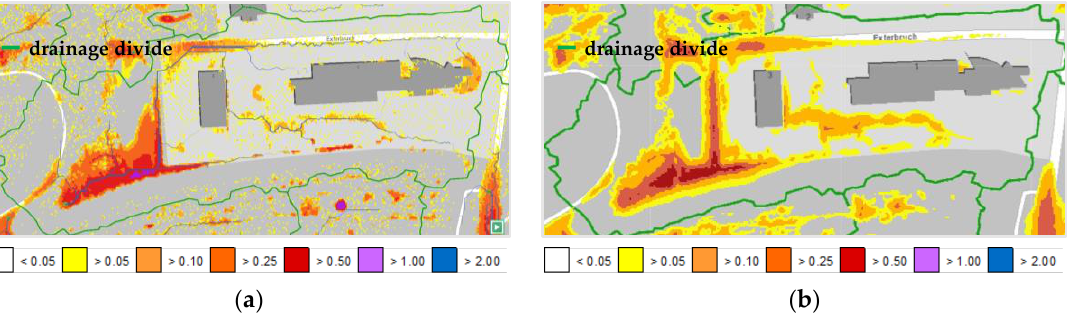
Figure 6. Predicted flood extent and depth after the precipitation: ( a ) reference flood map [30]; ( b ) simulation using Roe solver with the DEM-base roughness coefficient values.